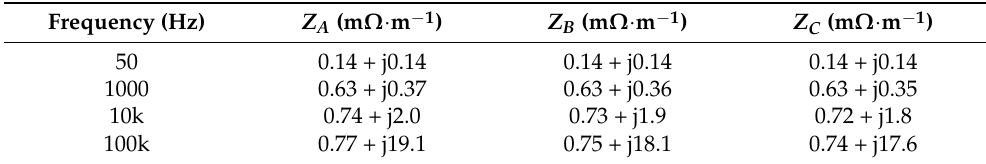
Table 1. Longitudinal impedances ( Z A , Z B , Z C ) of the three pile foundations per unit length at different frequencies.